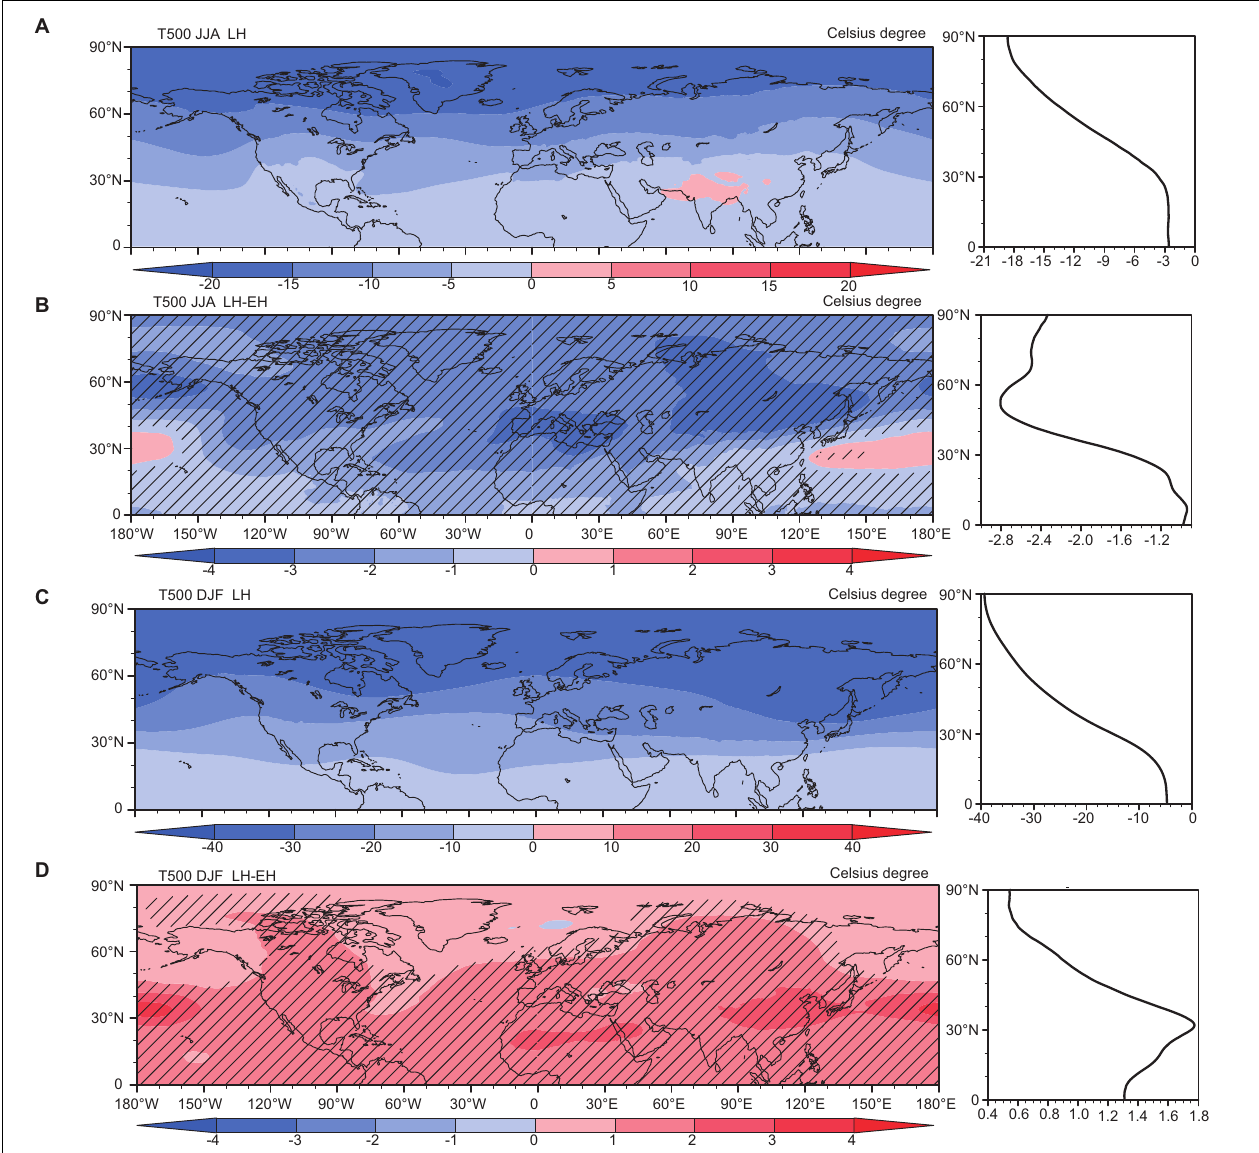
FIGURE 9 | The 500 hPa temperature distributions and the zonal mean temperature profiles. Summer and winter 500 hPa temperature distributions and zonal mean temperature profiles in LH (A,C) and the LH-minus-EH difference (B,D) . The line indicates the differences at the 95% significance level.